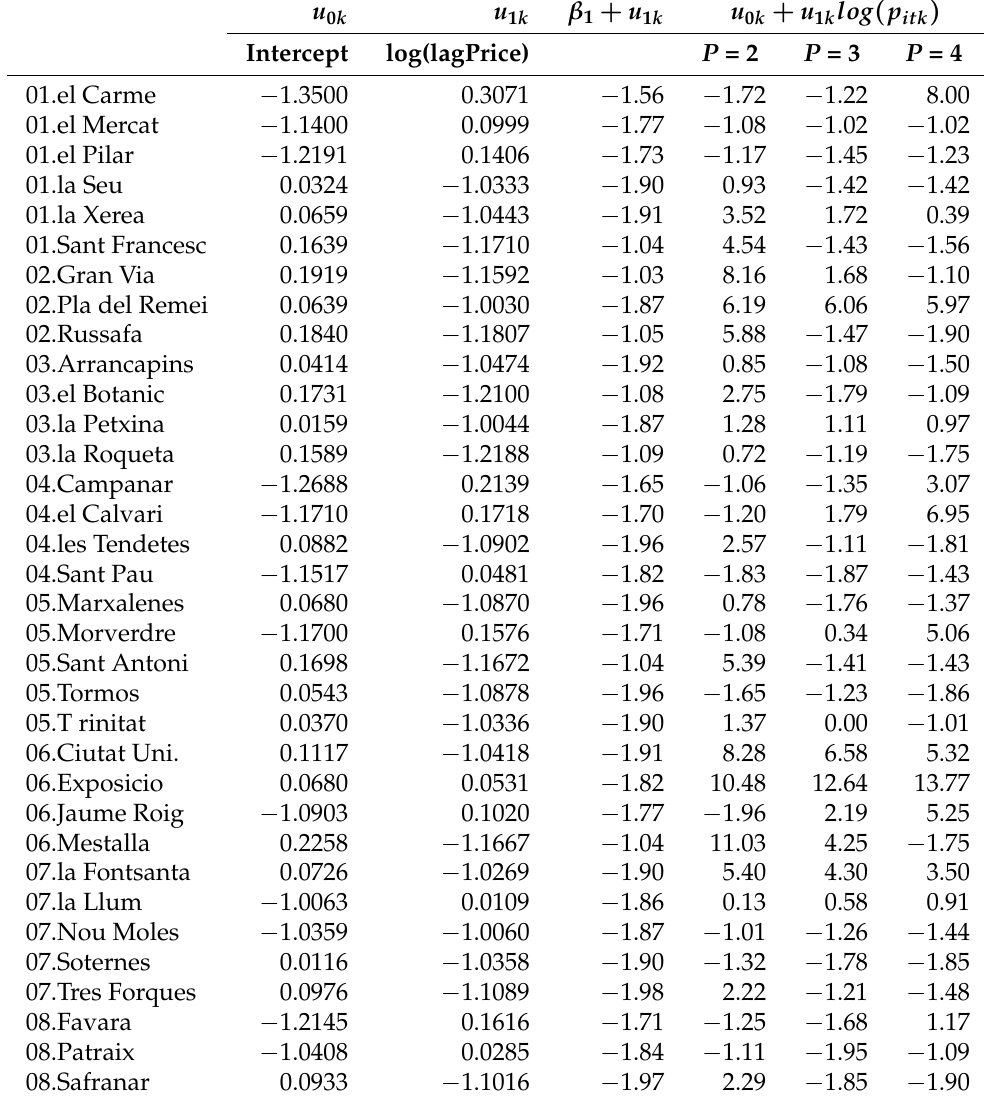
Table A3. Mixed model. Neighbourhood random effects. Elasticities and consumption